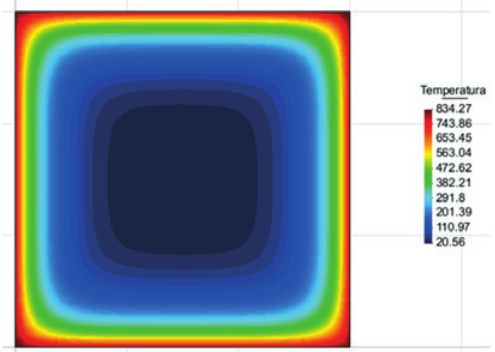
Figura 15a Campo de temperaturas para 30